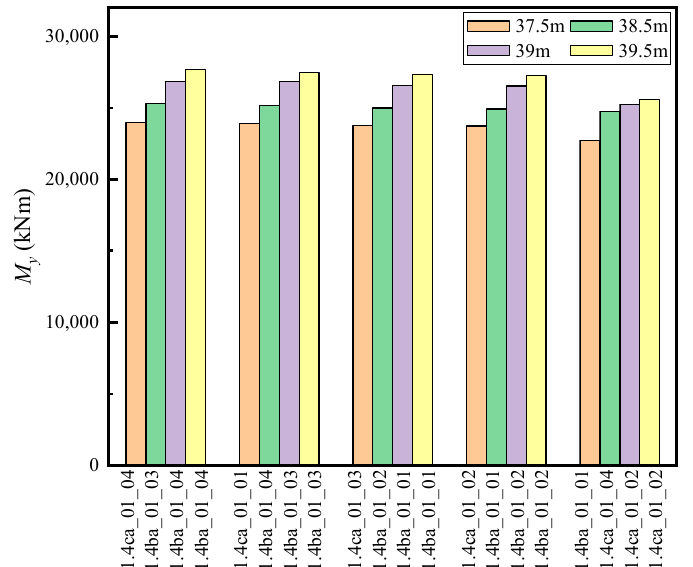
Figure 14. Histogram of M y at tower bottom. (The label of the load case: the first letter refers to wind speed, b for 11.5 m/s and c for 13.5 m/s; the second letter refers to yaw error and “a” for − 8 deg; the middle number refers to wind direction change and 01 for positive direction change; the last number refers to starting azimuth angle, 01 for 0 deg, 02 for 30 deg, 03 for 60 deg and 04 for 90 deg).